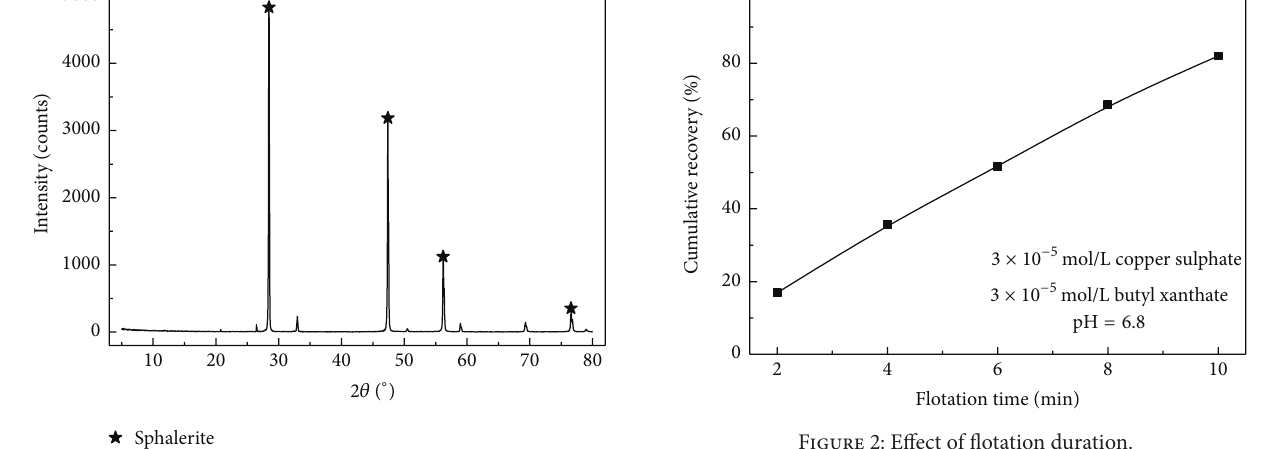
Figure 2: Effect of flotation